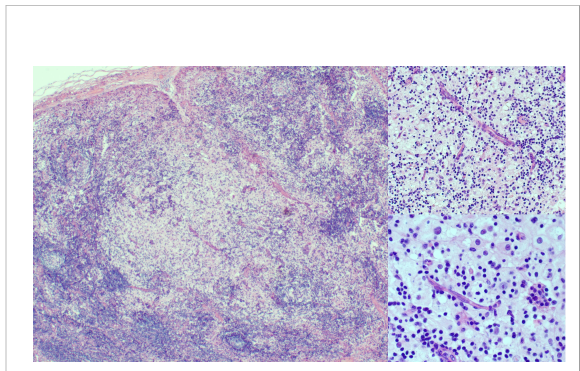
FIGURE 1 At hematoxylin and eosin (H&E), inguinal lymph node